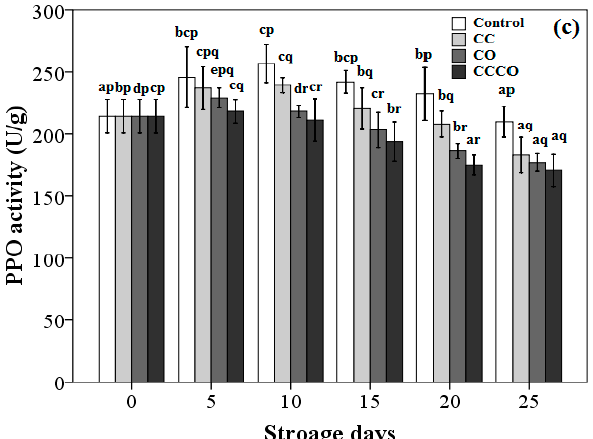
Figure 9. Effect of coating treatments on: the concentrations of O 2 and CO 2 in the packages ( a ); fruit decay ( b ); and PPO (Polyphenylene Oxide) activity of fruits ( c ). □ : Control; △ : Chitosan coating; ◇ : 0.25% Cinnamon oil; ○ : Chitosan coating containing cinnamon oil; CC: Chitosan Coating; CO: Cinnamon Oil, CCCO: Chitosan Coating containing Cinnamon oil. Mean bars with different letters (a–e) differ significantly among different storage days for the same treatment at p < 0.05. Mean bars with different letters (p–r) differ significantly among different treatments for the same storage days at p < 0.05.